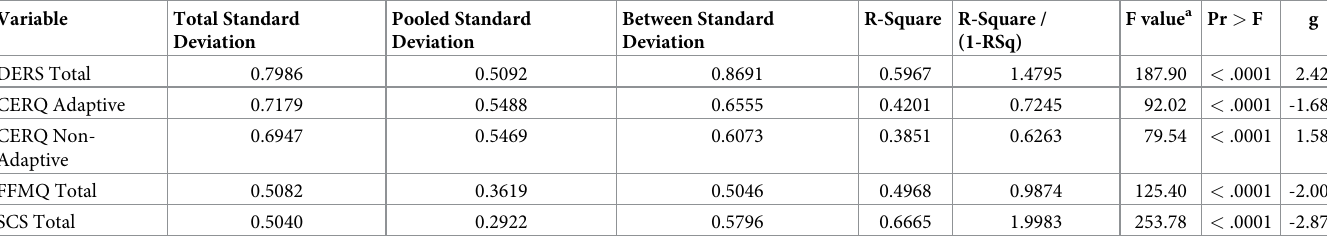
Table 3. Group comparisons for the total scores of the four scales.